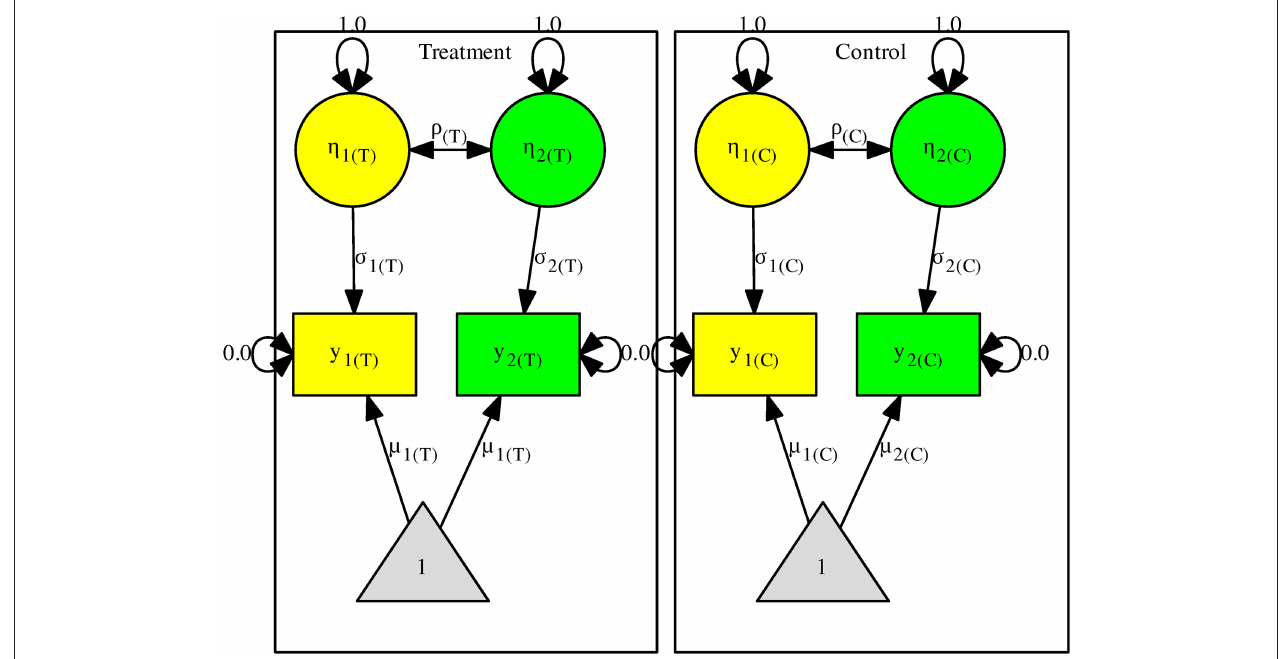
FIGURE 2 | The structural equation model for the multiple-endpoint